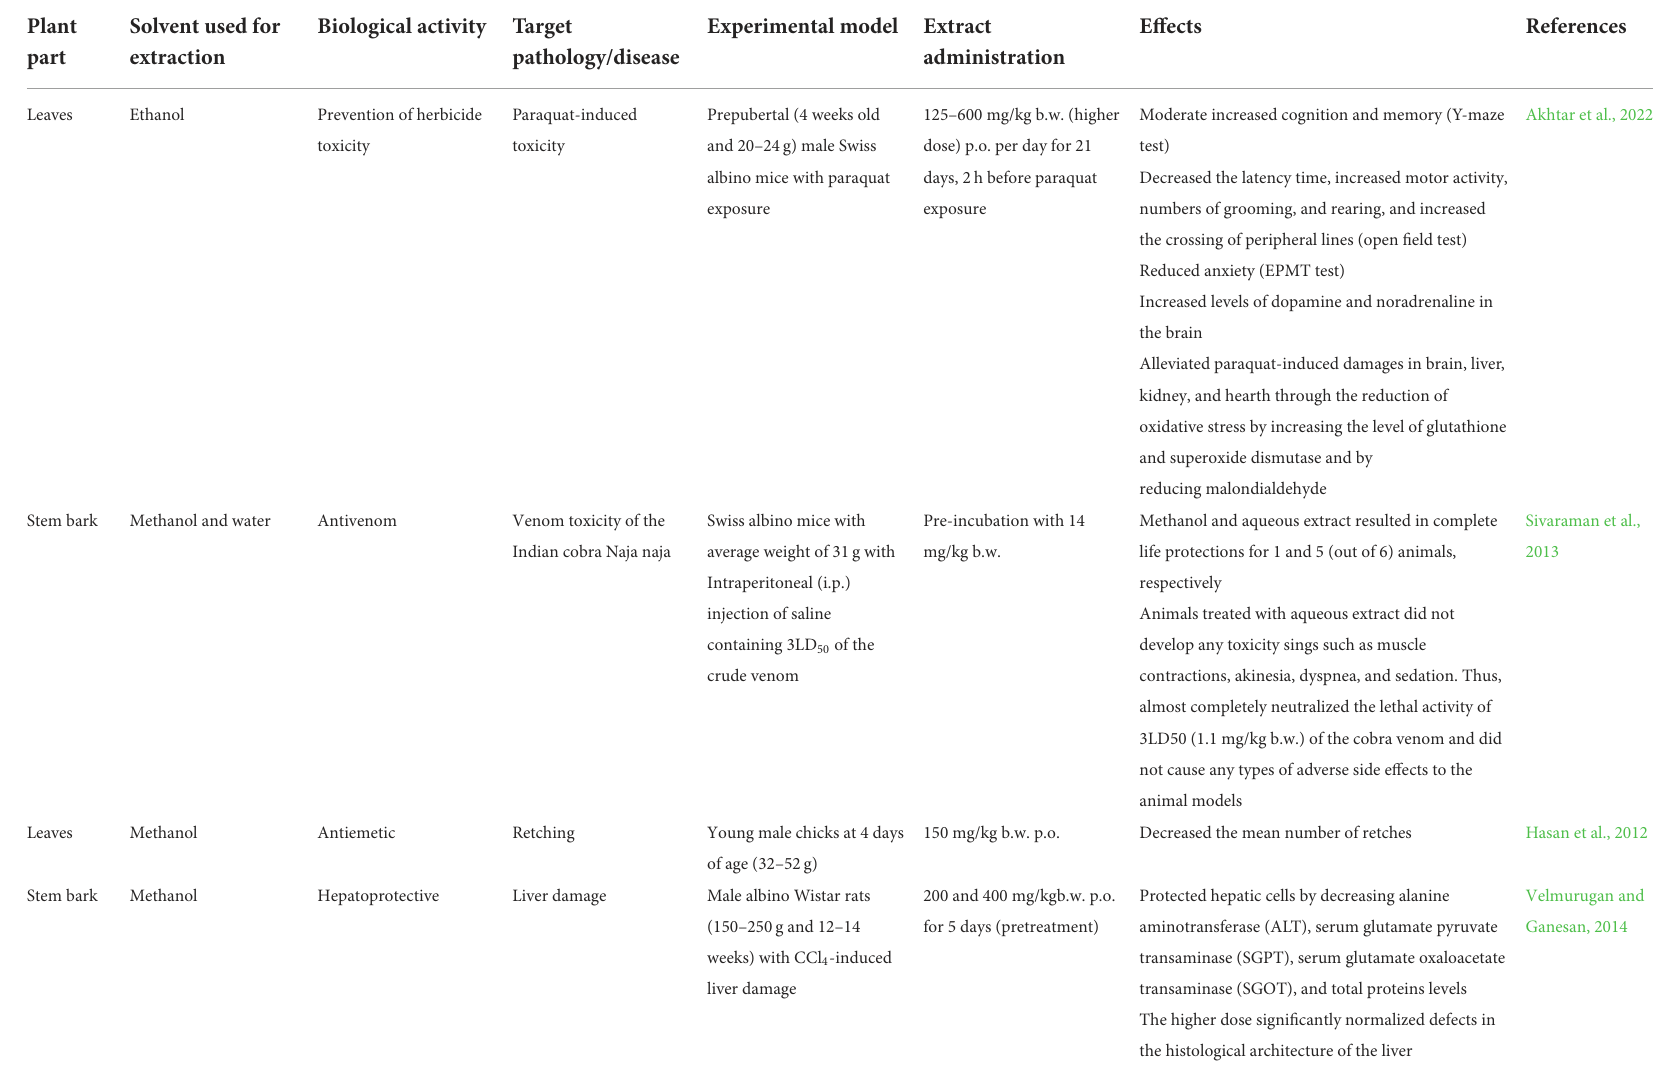
TABLE 1 Prosopis cineraria main medical